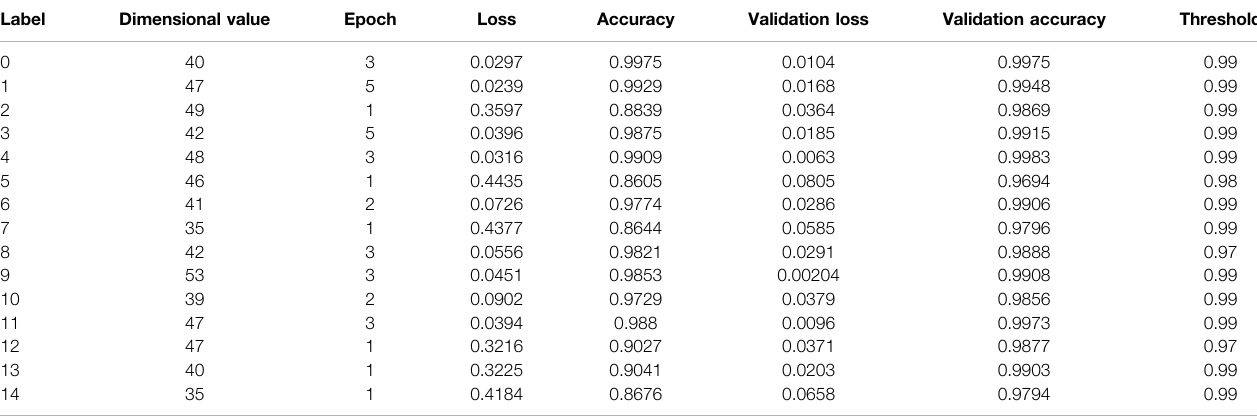
TABLE 1 | The primary parameters and training results of the optimized model for the identi fi cation of therapeutic monoclonal antibodies. Label Dimensional